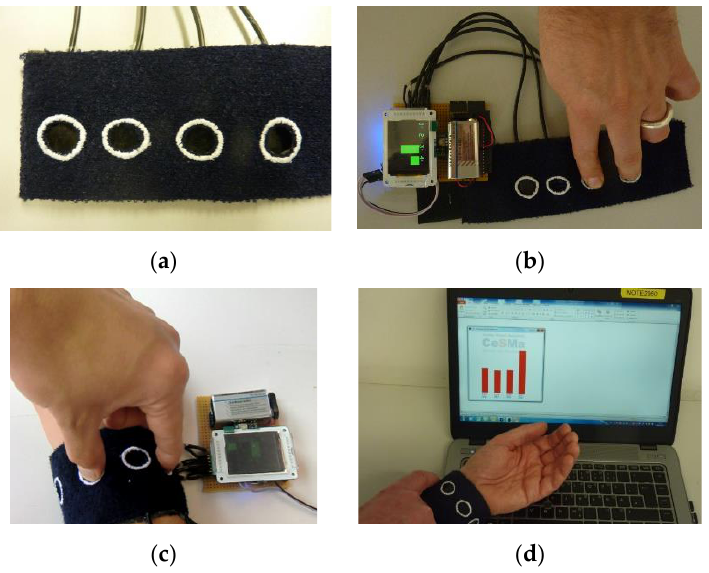
Figure 24. Wristband with four pressure sensors ( a ) with electronics ( b ), in operation by a user ( c ) and with wireless data transfer via Bluetooth to a computer ( d ) [103].